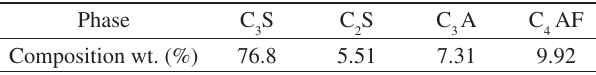
Table 2. Mineralogical composition of Portland cement.